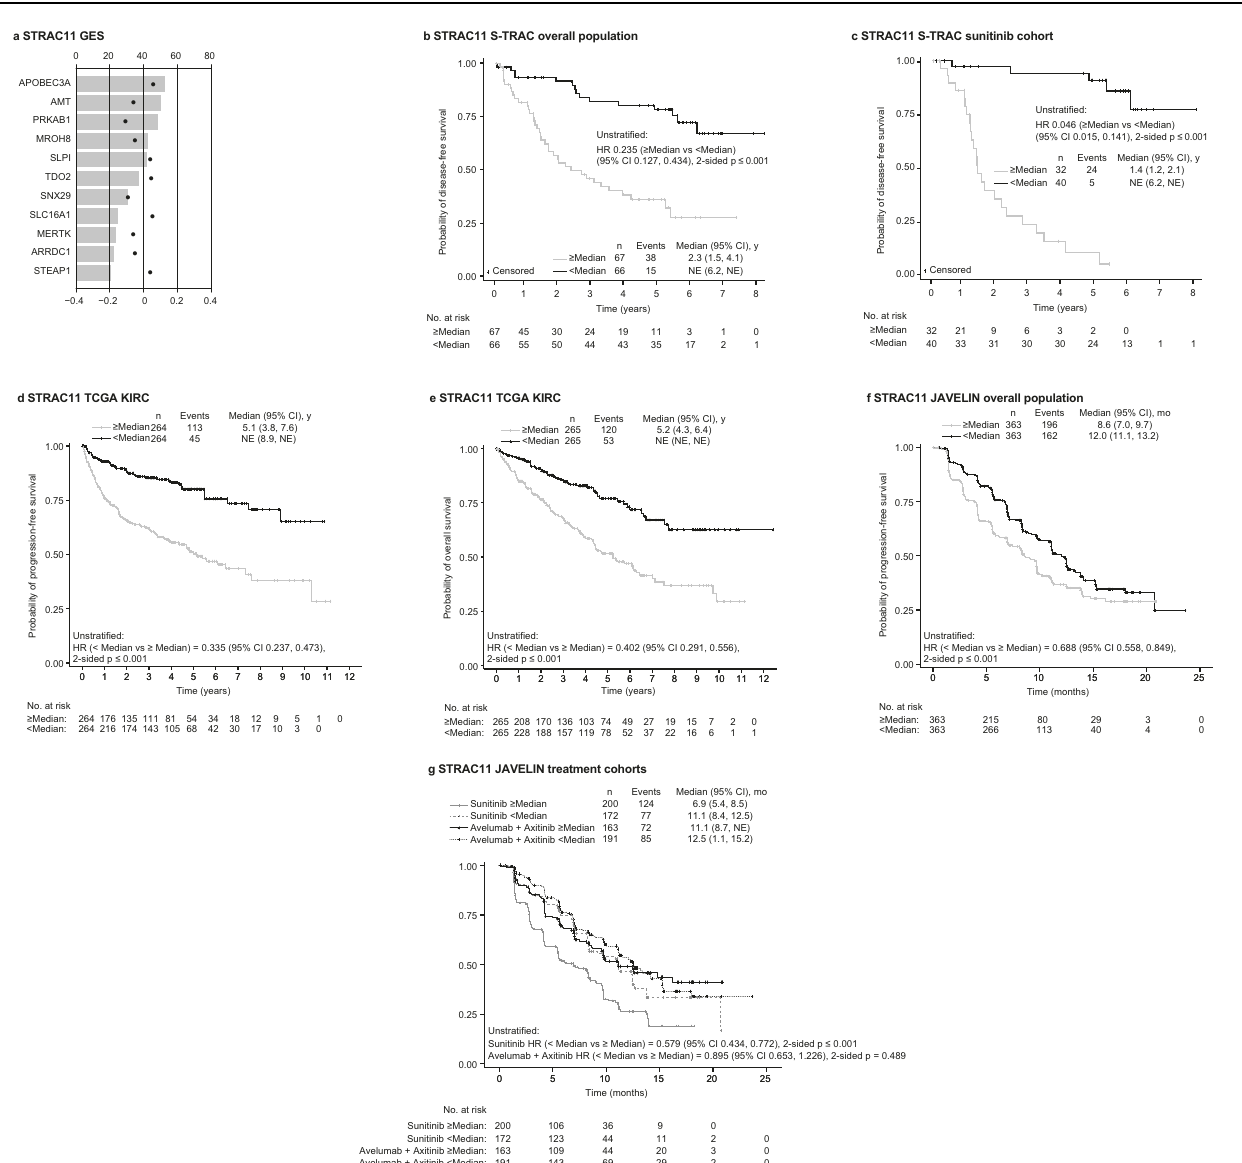
Fig.5|Identi fi cationoftranscriptomicsignaturesassociatedwithahighriskof recurrence and poor prognosis. a Discovery of the STRAC11 GES [derived from the sunitinib-treated S-TRAC trial population] according to bootstrapping fre- quency. Kaplan – Meier plot of b differential DFS probability by STRAC11 in the S-TRAC placebo arm and c sunitinib arm. Kaplan – Meier plot of differential d PFS probabilityand e OSprobabilitybySTRAC11intheTCGAdataset; f differentialPFS bySTRAC11intheJAVELINRenal101overallpopulationdatasetand g bytreatment arm. AMT aminomethyltransferase, APOBEC3A apolipoprotein B mRNA